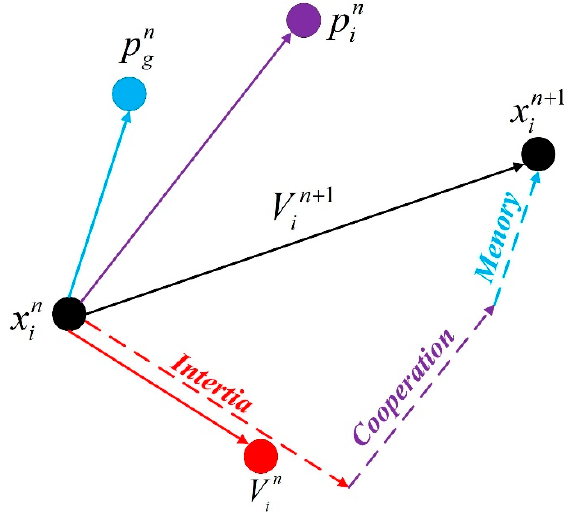
Figure 2. The process of the PSO algorithm.